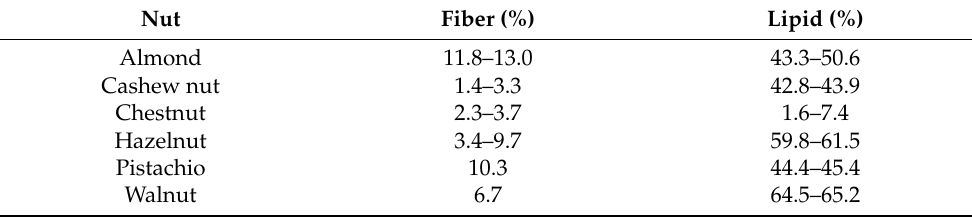
Table 4. Fiber and lipid contents (%) of selected nuts (adapted from Amarowicz et al. [68]).